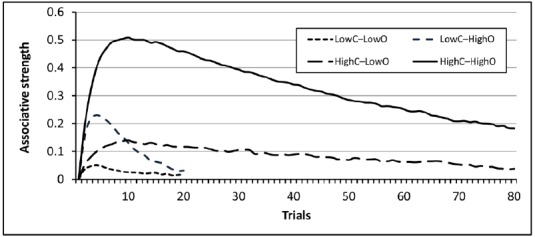
Results of a computer simulation of the four experimental conditions presented by Blanco et al. (2013, Experiment 1) using the Rescorla–Wagner learning algorithm. The simulation was conducted using the Java simulator developed by Alonso et al. (2012). For this simulation, the learning rate parameters were set to αcause = 0.3, αcontext = 0.1, βoutcome = β∼outcome = 0.8.